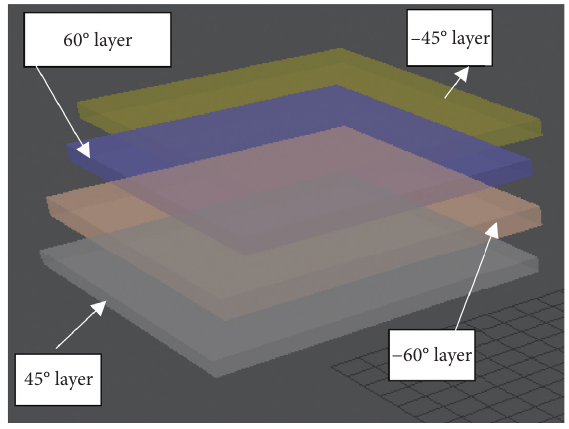
Figure 3: 4-Layered plate (45 ° / − 60 ° /60 ° / − 45 ° ).